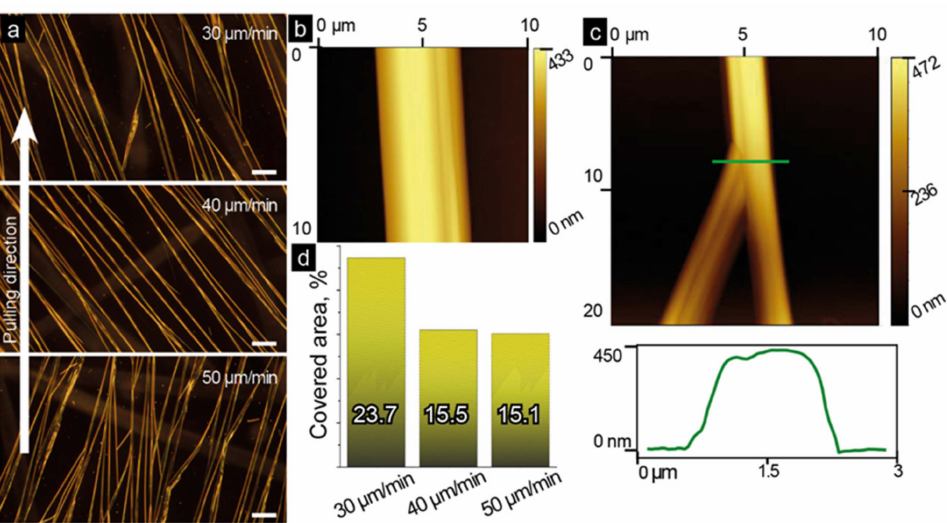
Figure 2. Morphology of quasi-regular belt-like FF microstructures: ( a ) optical dark-field images of belts grown at different pulling velocities (scale bar: 50 µ m). All images are taken for the same sample orientation as they were pulled out. The white arrow shows the pulling direction. ( b ) AFM topog- raphy image of a microbelt; ( c ) AFM topography image of the microbelt split, and its cross-section along the green line; ( d ) the estimated coverage area for samples pulled with different